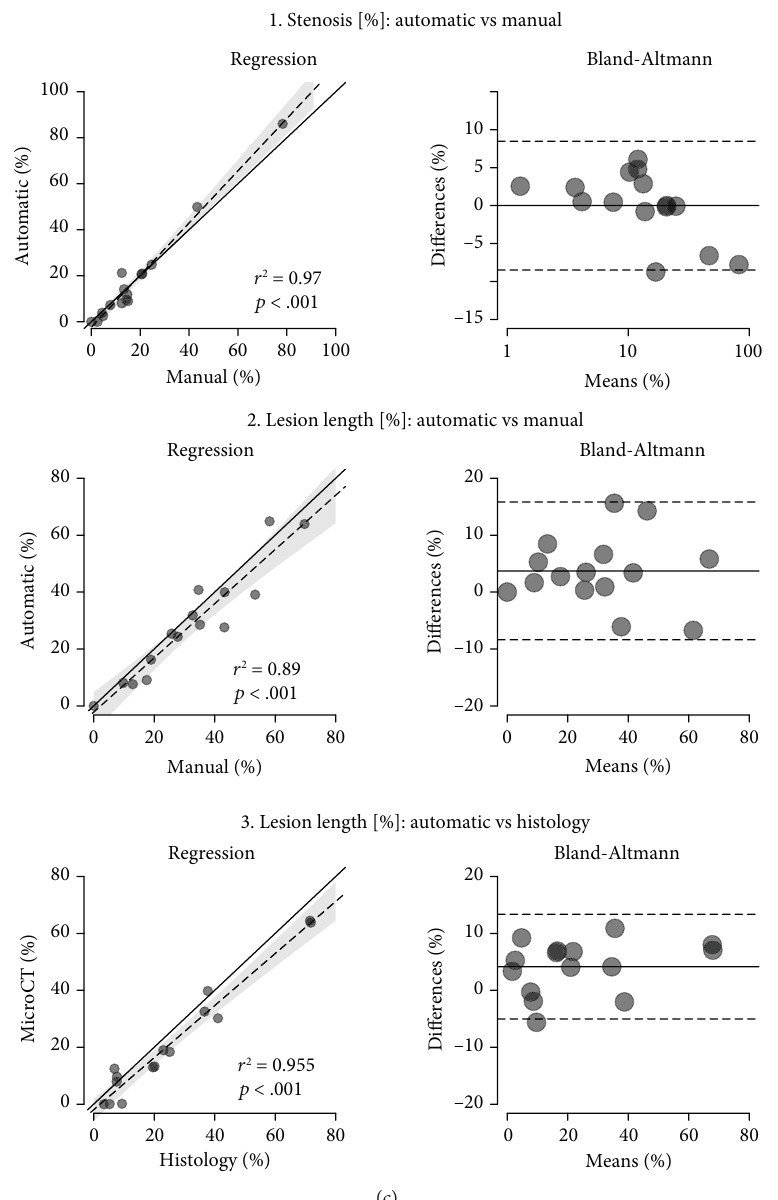
Figure 2: Validation against manual and histopathological measurements. (a) Seven representative sections for visual comparison of grayscale and automatically segmented microCT sections along the aorta illustrating excellent qualitative agreement. (b) Four representative pairs of equivalent microCT and histological slices (hematoxylin-eosin staining) aligned using rigid registration illustrating the good agreement between methods (p: plaque; L: lumen; w: wall; bar = 400 μ m). (c) Quantitative analysis: regression and Bland- Altman plots showing very good agreement between (1 and 2) automatic and manual measurements and no bias ( r 2 ≥ 0 : 89 ; p < : 001 ) and (3) very good agreement between microCT and histology ( r 2 > 0 : 95 ; p < 0 : 001 ) with slightly lower ( ~ 5%) measurements in microCT, but evenly distributed errors suggest no